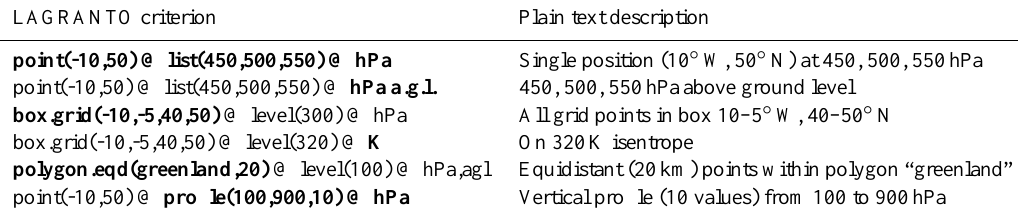
Table 1. Some examples of the creation of starting files (see Sect. 3.2). A typical call would be of the form startf YYYYMMDD_HH startf criterion , where the first argument defines the starting date of the calculation, startf is the name of the file with the starting positions, and the criterion, as given in the left column, specifies the positions. Only the part in bold font of the specification is explained in the right column. LAGRANTO criterion Plain text description